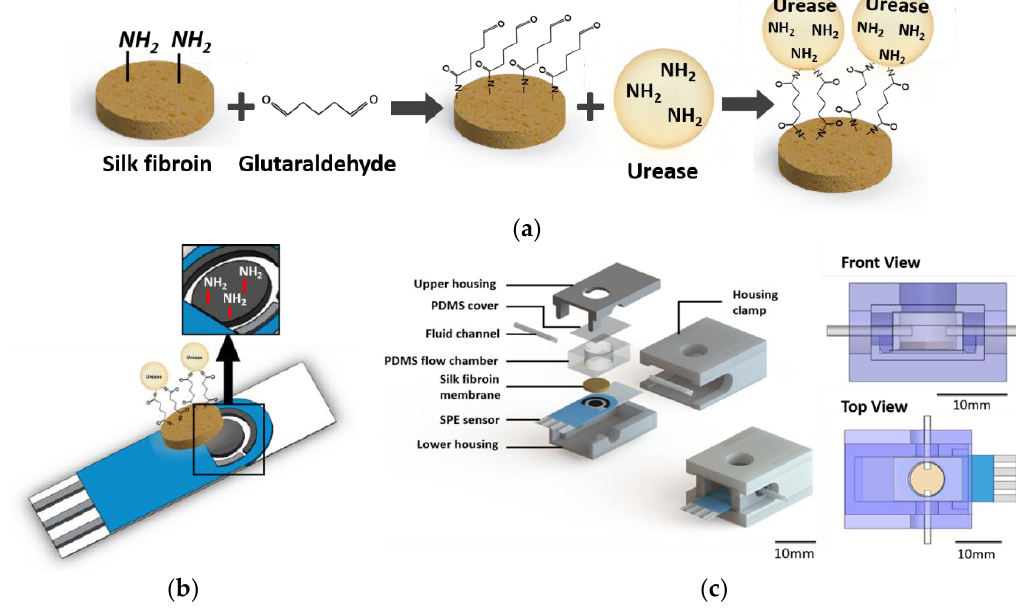
Figure 1. Schematic diagram of ( a ) the principle of immobilization of urease on the silk fibroin (SF) membrane, ( b ) the amination of the surface of the carbon electrode, and ( c ) the configuration of the sensor system.